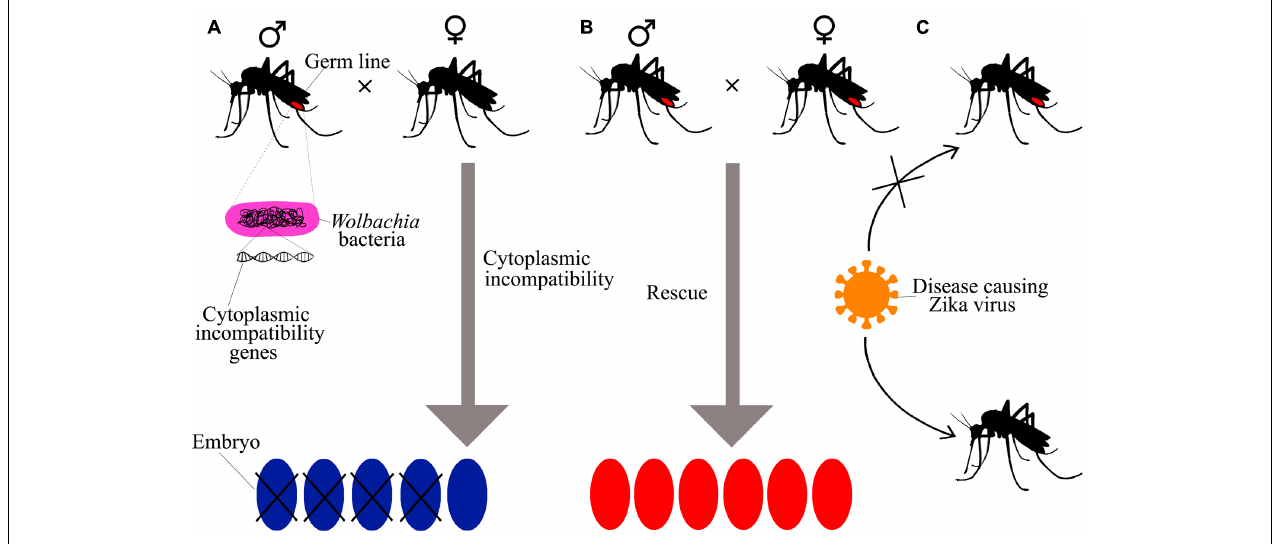
FIGURE 4 | The preventive action of Wolbachia spp. on ZIKV by cytoplasmic incompatibility (CI) to prevent transmission of disease. (A) The bacteria Wolbachia spp. infect the germ lines of mosquitoes and only female can transfer the bacteria to the next generation. The mating between bacteria infected males and uninfected females resulted in embryo lethality are known as CI, a major approach used to restrain insect populations in some pest-management systems. (B) CI may prevent in rescue mating between bacteria infected males and bacteria infected females. Because the effect of bacterial infection on the reproduction of insect supports the survival of bacteria infected females over uninfected females, bacteria might quickly spread during population of insect. (C) The bacterial infection can avert mosquitoes from being infected by some viruses that infect human host and the spread of the bacteria by an insect population is being used to prevent insect-mediated human diseases as per Sullivan and O’Neill